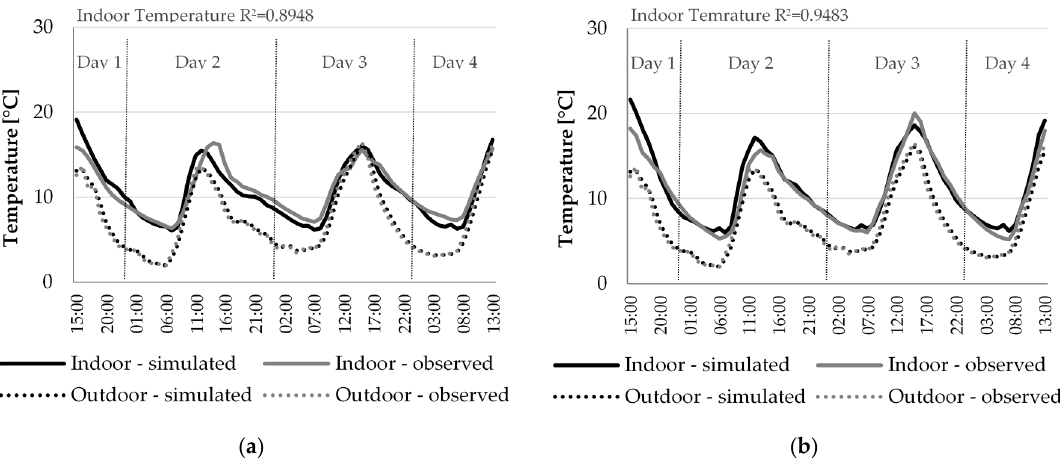
Figure 5. Indoor and outdoor dry bulb temperature plots of observed and predicted data; ( a ) Case A; and ( b ) Case